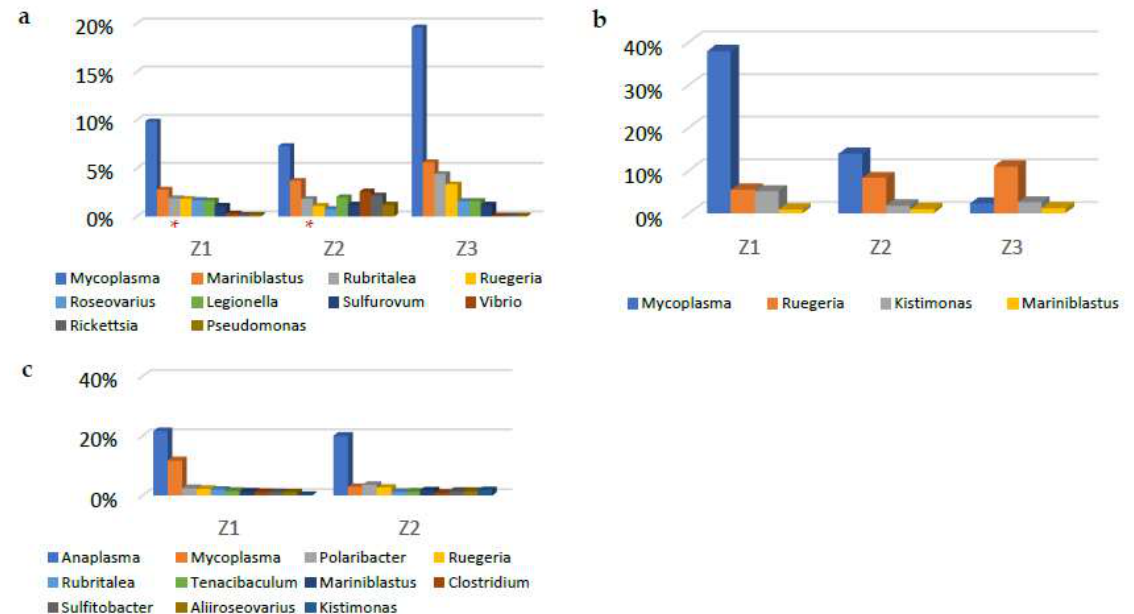
Figure 3. The most abundant bacteria at the genus level in the different zones of Chalastra and Mak- rigialos regions. ( a ) Chalastra winter, ( b ) Chalastra summer and ( c ) Makrigialos winter. Statistically non-significant pairwise comparisons are marked with an asterisk.